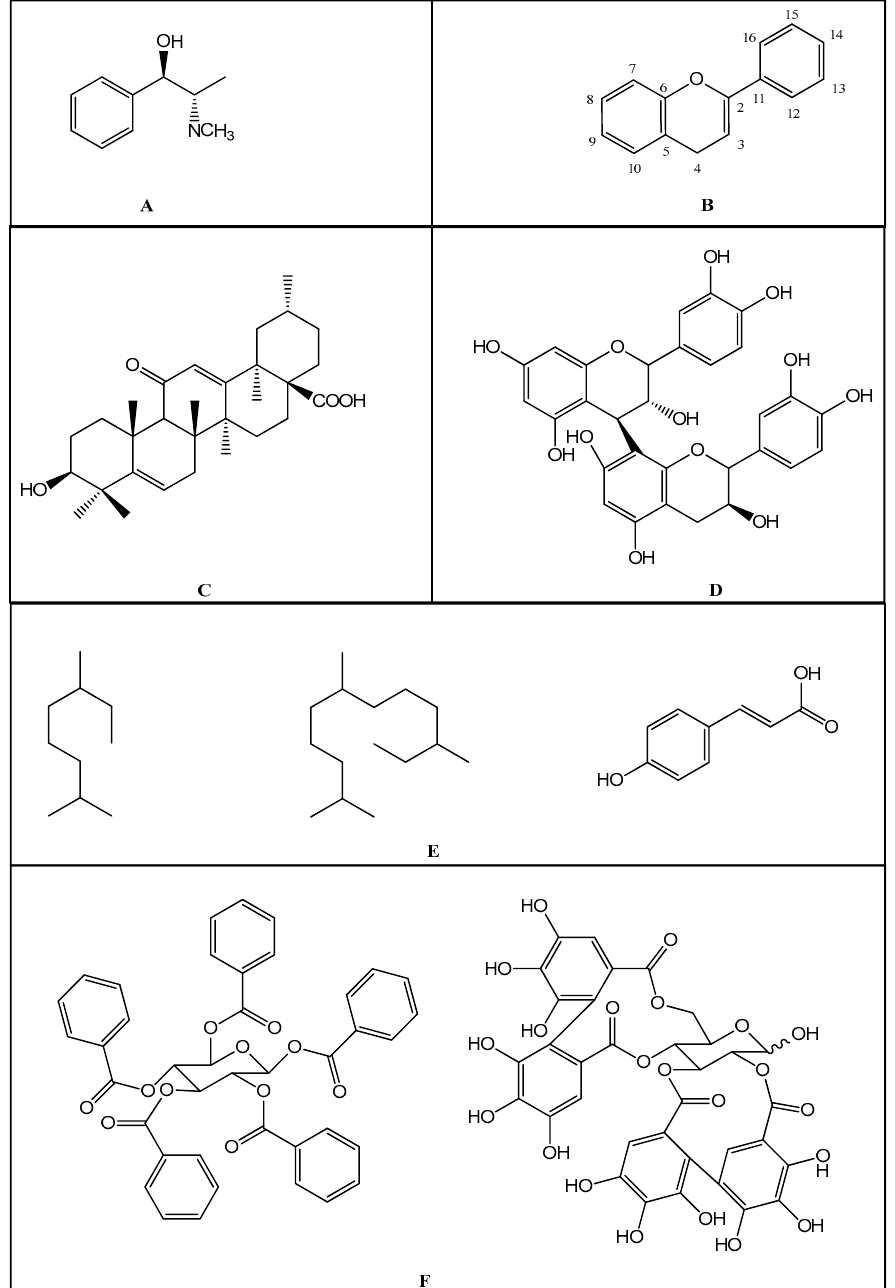
Figure 1. ( A ): Chemical structure of alkaloids: Ephedrine. ( B ): Basic Flavonoid Structure, ( C ): Chemical Figure 1. A : Chemical structure of alkaloids: Ephedrine. B : Basic Flavonoid Structure, C : Chemical structure of saponins: Glycyrrhizin, ( D ): Structure of condensed tannin, ( E ): Structure of terpenoids structure of saponins: Glycyrrhizin, D : Structure of condensed tannin, E : Structure of terpenoids and and phenylpropanoids, ( F ): Structure of hydrolysable tannins: Galotannins and Ellagitannins phenylpropanoids, F : Structure of hydrolysable tannins: Galotannins and Ellagitannins [74,90].